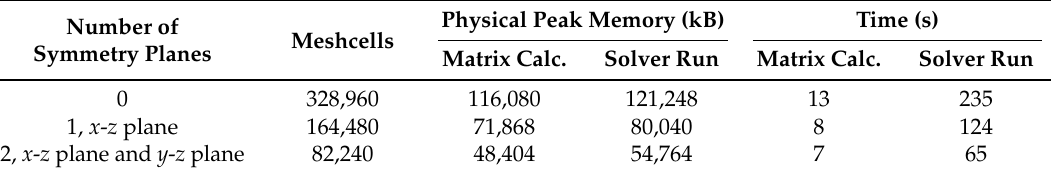
Table 1. Model A : Wire embedded in a fictitious half-space dielectric media. Computational Time and Memory Resources versus Symmetry Planes for a Relative Permittivity